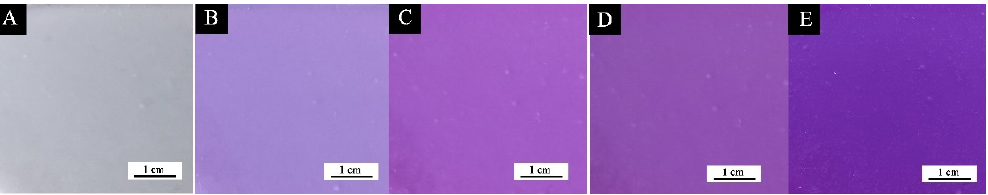
Figure 9. Discoloration process of the coating on the metal substrate with 10.0% microcapsules. Visible light exposure time: ( A ) 0 s, ( B ) 5 s, ( C ) 10 s, ( D ) 15 s, ( E ) 20 s.